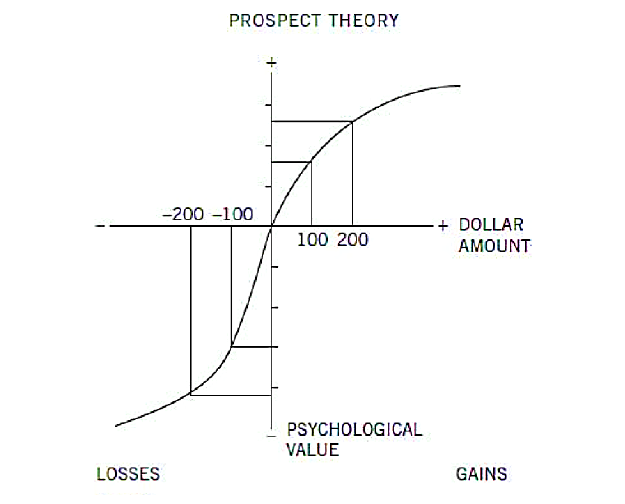
Figure 1. Value function curve